Question: Looking at the figure, what chart type is it?
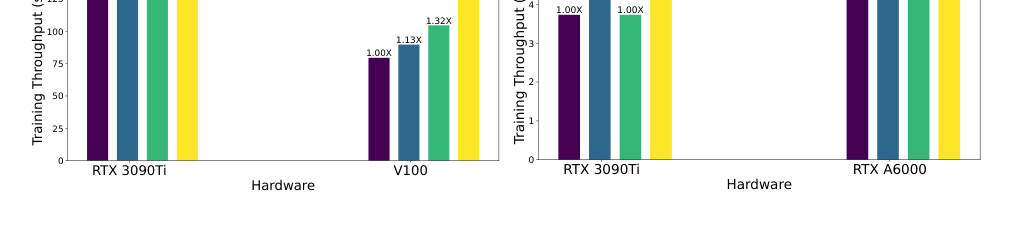
Answer: line